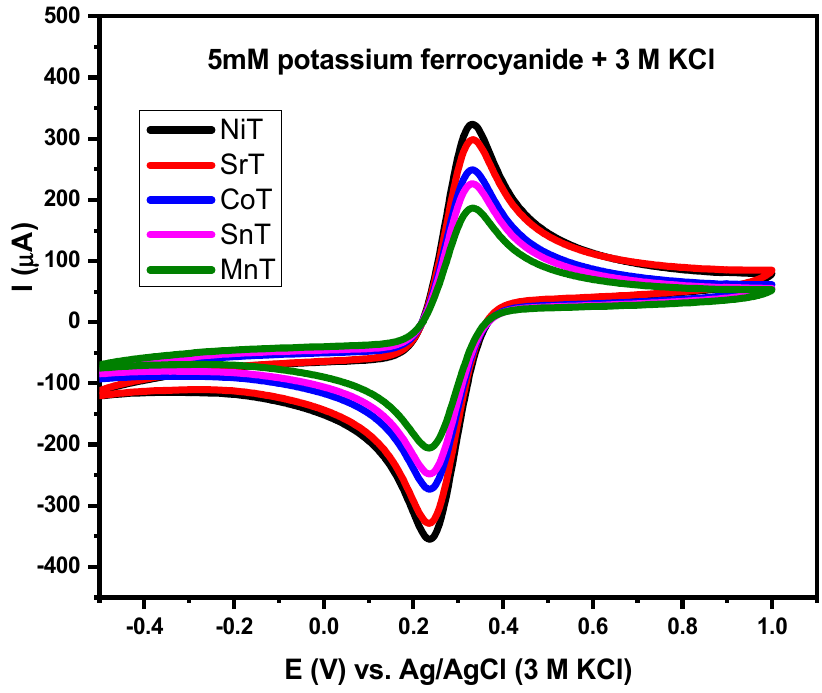
Figure 9. Cyclic voltammogram in 5 mM of potassium Ferrocyanide redox couple, with 0.1 M KCl as the supporting electrolyte at a 100 mV s − 1 sweep rate at the surface of the modified GC.